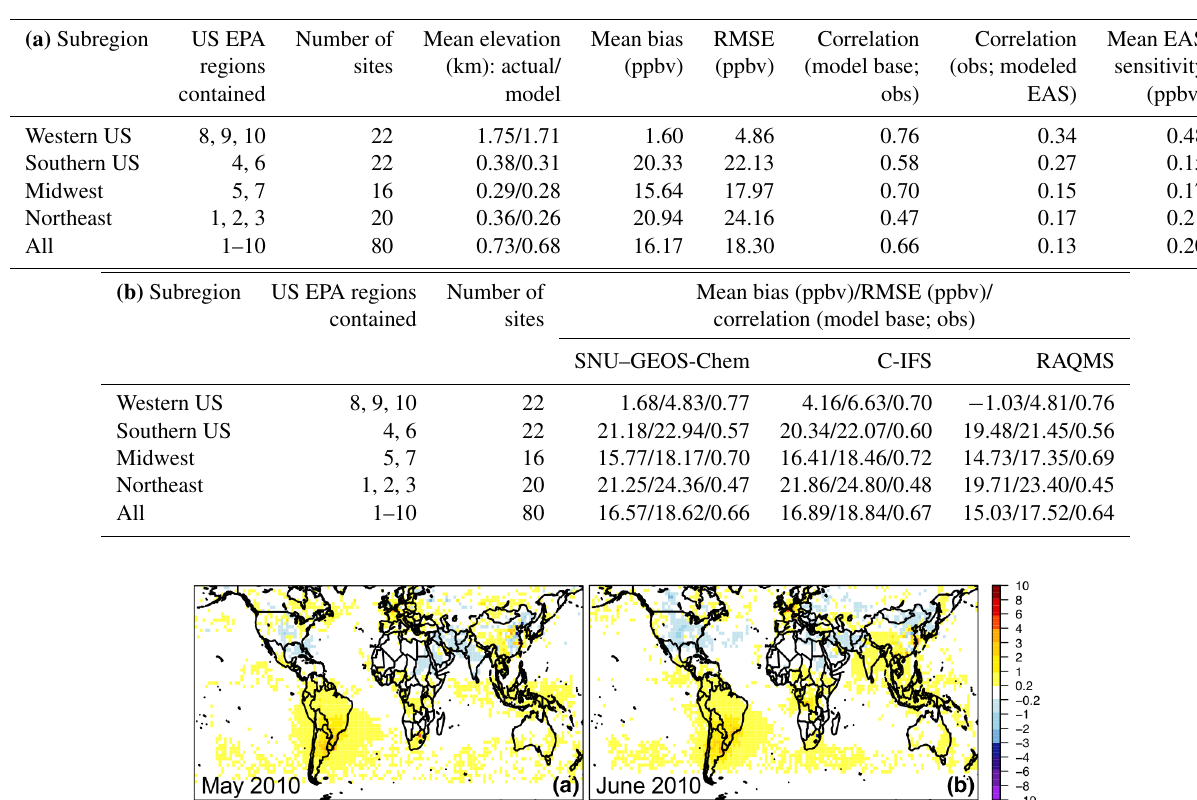
Table 3. (a) Evaluation of the hourly STEM-simulated total O 3 (averaged from the three base simulations that used the different free-running boundary conditions) against the CASTNET surface observations for 8 May–30 June 2010. The subregional-mean R (O 3 , EAS, 20%) and its correlation coefficient with the observed O 3 are also shown. (b) Evaluation of the hourly STEM-simulated total O 3 (separately for three base simulations that used the different free-running boundary conditions) against the CASTNET surface observations for 8 May–30 June 2010.